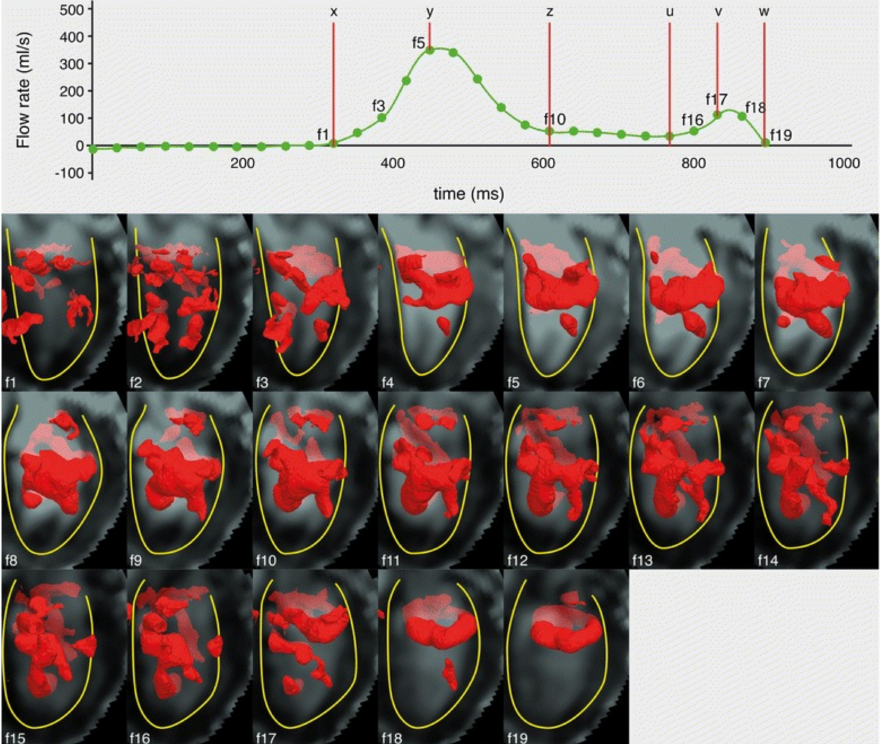
Figure 2. LV vortex structures visualised as isosurfaces in red colour using the Lambda2 method over the diastolic phase of a sample normal subject ( f1 – 19 ), with E-filling onset (x), peak (y) and end (z), and A-filling onset (u), peak (v), and end (w) marked on the flow rate time curve (top panel). The compact vortex ring formed between early ( f3 ) and late ( f7 ) diastolic filling became most developed during early- ( f5 ) and A-filling ( f18 ), and continued to the end of late filling ( f19 ) [26]. Permission to reproduce obtained under the Creative Commons Public Domain Dedication waiver via Springer